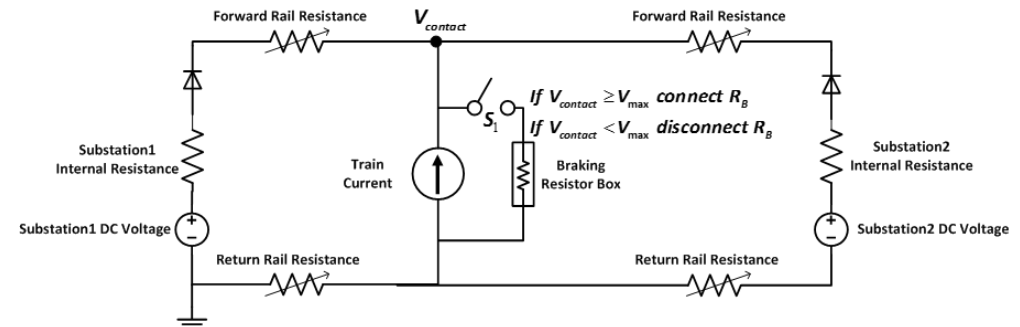
Figure 12. Schematic representation of a train with a braking resistor box.